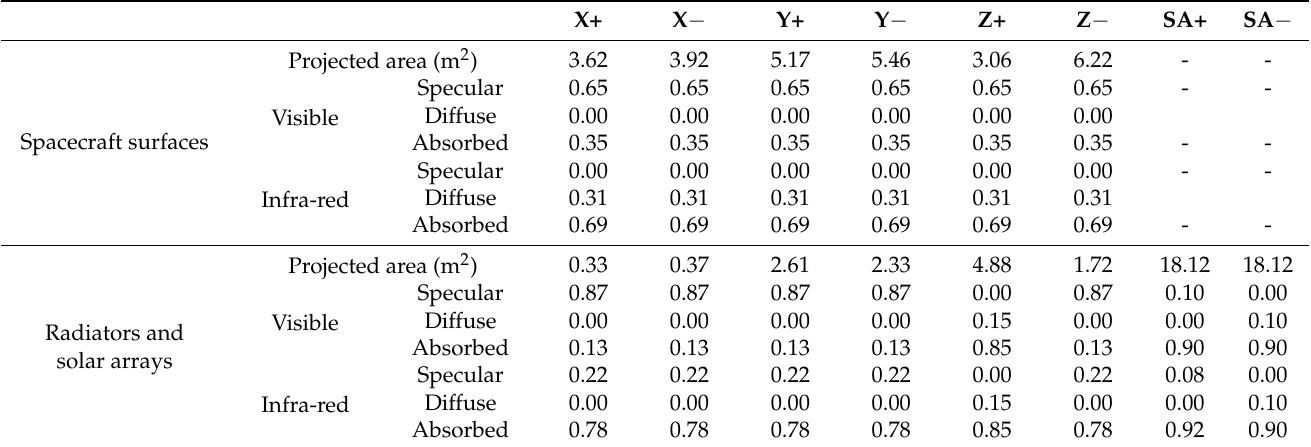
Table 2. Projected areas and optical characteristics of